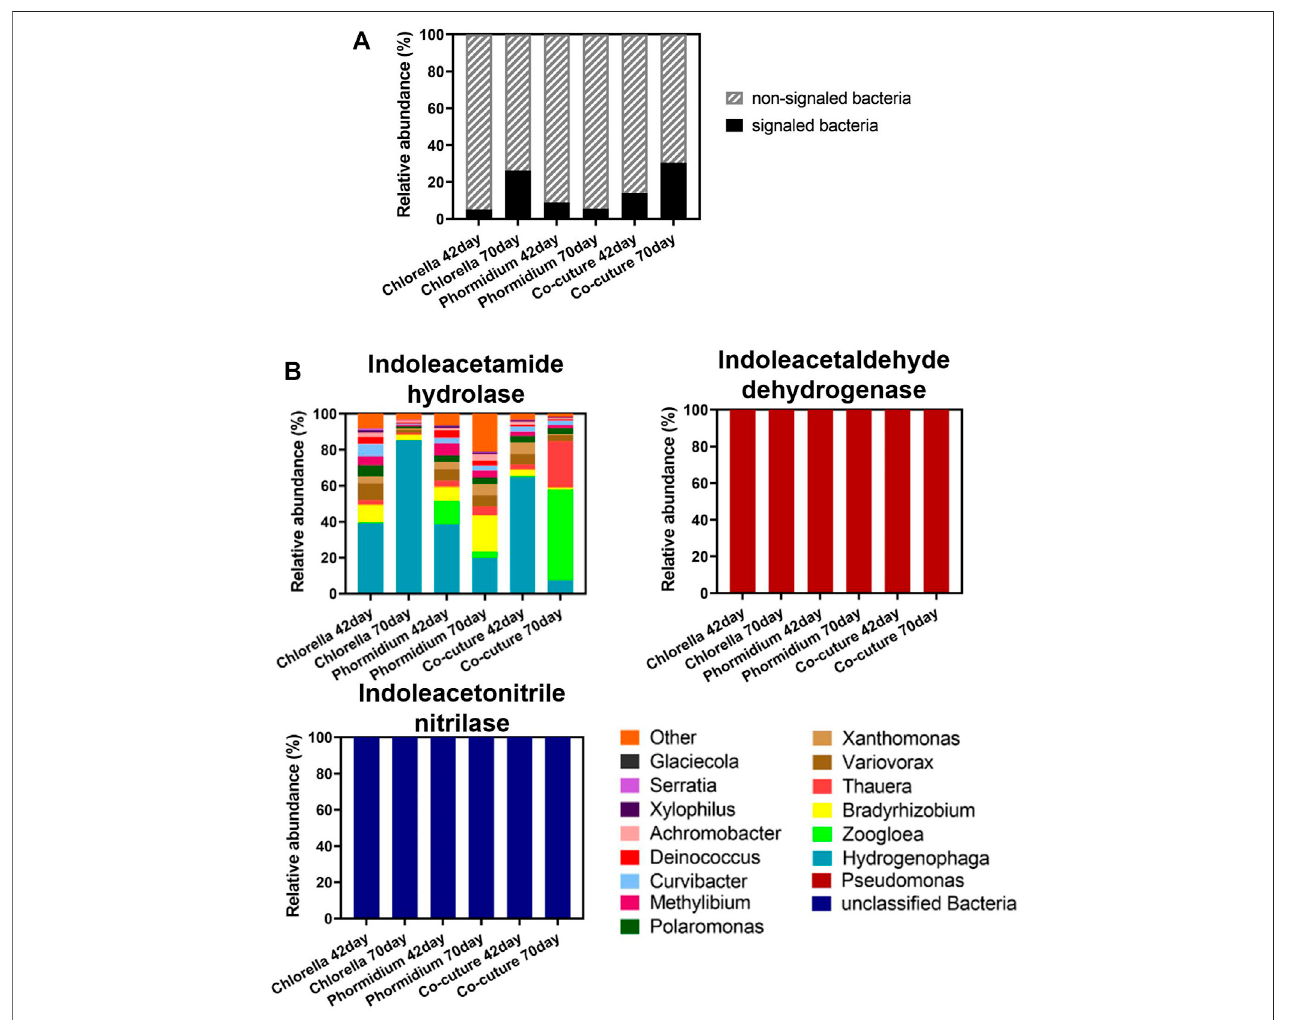
FIGURE 7 | Community structure of signaled bacteria. (A) Subcommunity of signaled bacteria carrying IAA synthetase. (B) The relative abundance of signaled bacteria carrying IAA synthetase in the bacterial community.